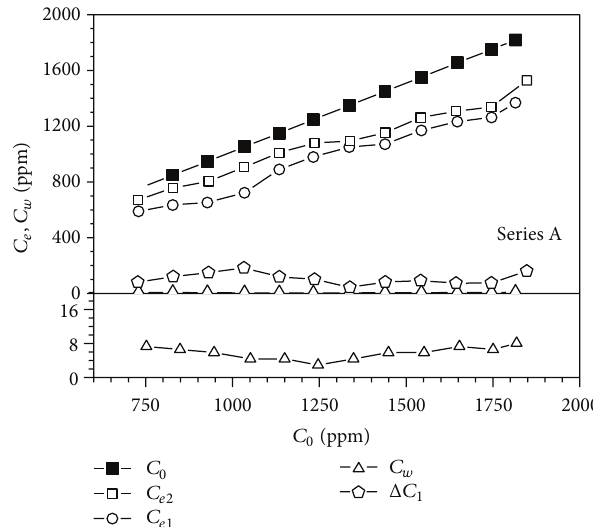
Figure 1: The adsorption experiment of two-phase and three-phase systems with the simulative water A.